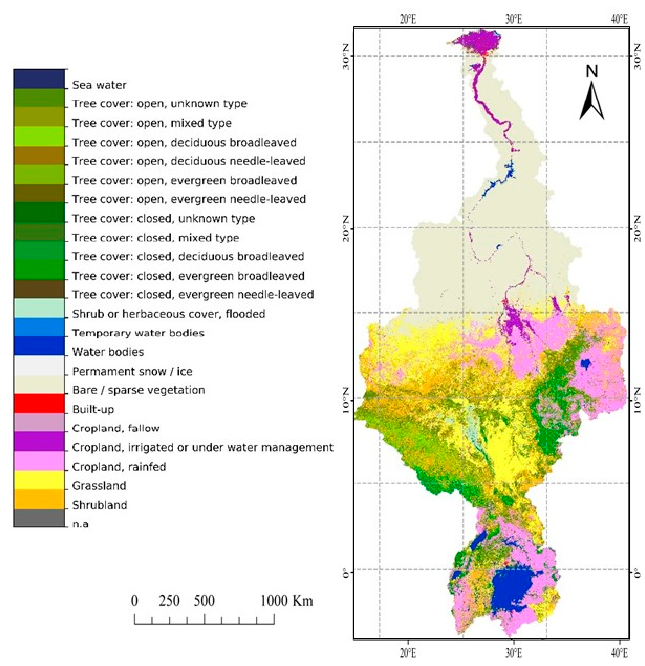
Figure 2. Land cover pattern in the NRB. Table 2. Land-use variation in the NRB countries from 2009–2020.